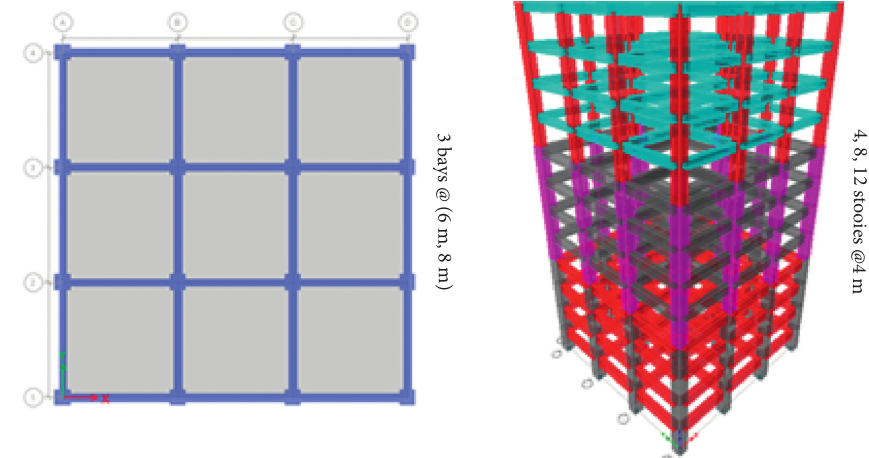
Figure 9: Plan and elevation of the reinforced concrete